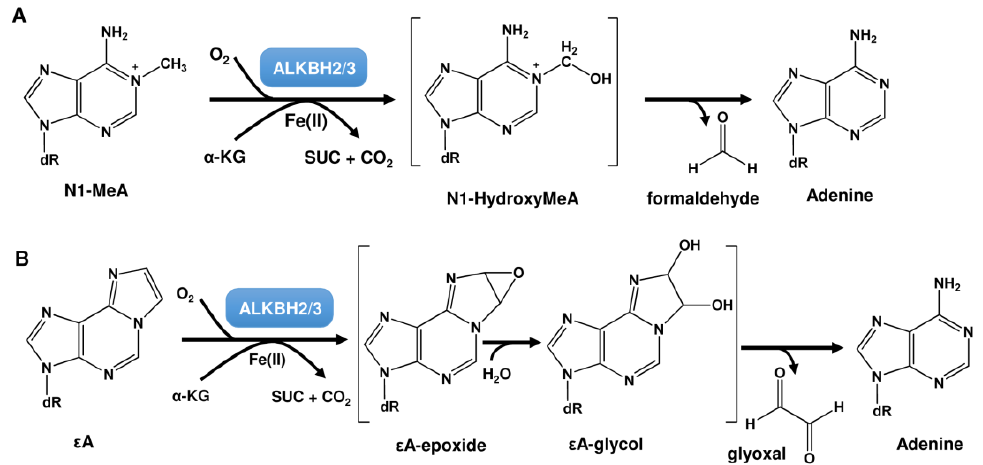
Figure 8. ALKBH-mediated repair of ( A ) N1-MeA and ( B ) εA. α -KG: alpha-ketoglutarate; SUC: suc- cinate; dR: deoxyribose moiety. succinate; dR: deoxyribose